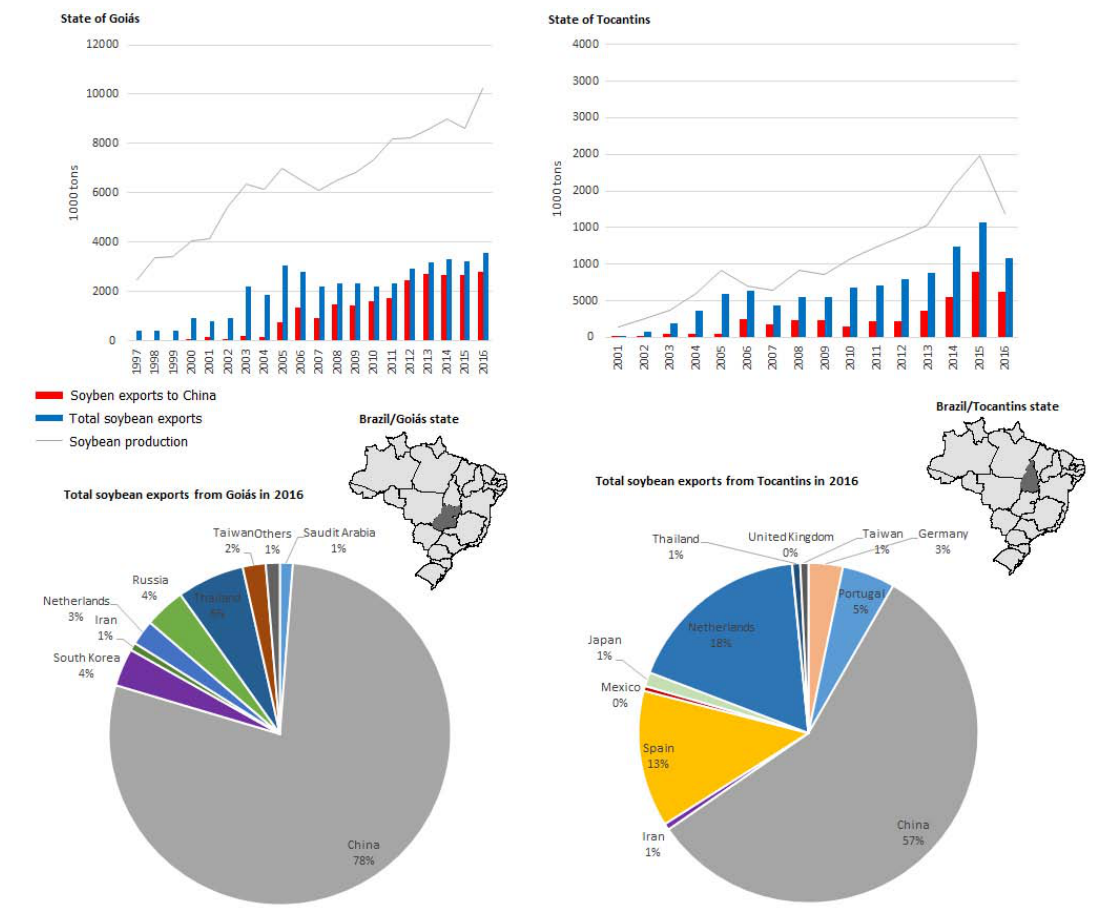
Figure 3. Export destinations of soybean produced in Goi á s and Tocantins, Brazil (AGROSTAT, Supplementary Material